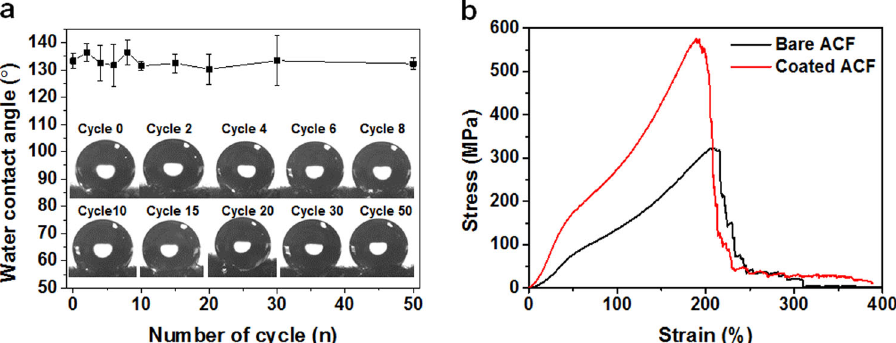
Fig. 6 Durability and mechanical properties of F-PU in-and-out coated ACF. a Water contact angle of the F-PU in-and-out-coated ACF after the scratch test. b Tensile strength of the bare ACF and F-PU in-and-out-coated ACF. The error bars represent the standard deviations of the data.